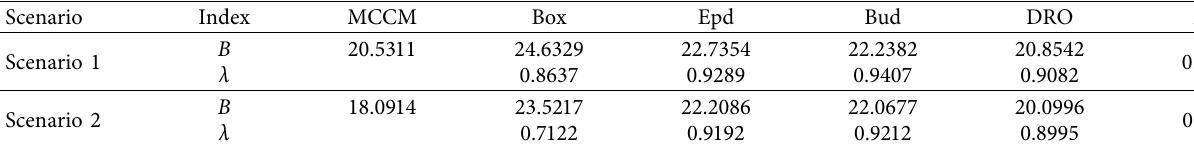
Table 5: Comparison with the results of other minimal consensus models.